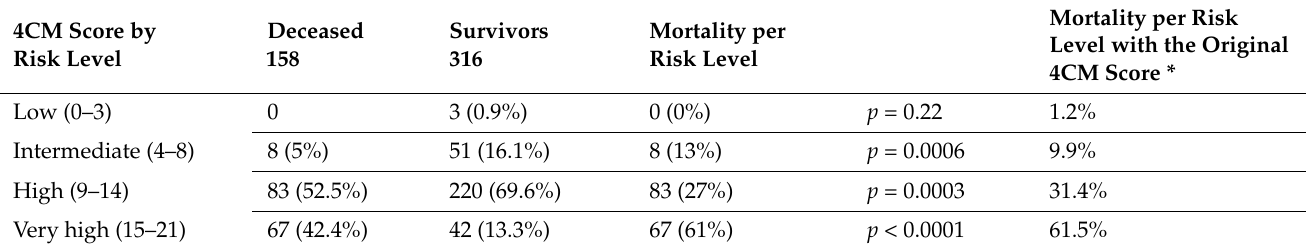
Table 2. Mortality rates according to the 4CMS risk